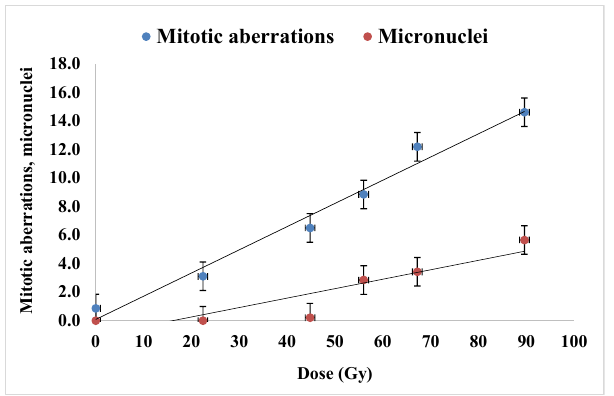
Figure 6. Linear increase of mitotic aberrations and micronuclei in the samples corresponding to proton beam exposure at the Bragg peak. For each experimental variant, between 2300 and 3100 data collected from the microscopy investigation were used .